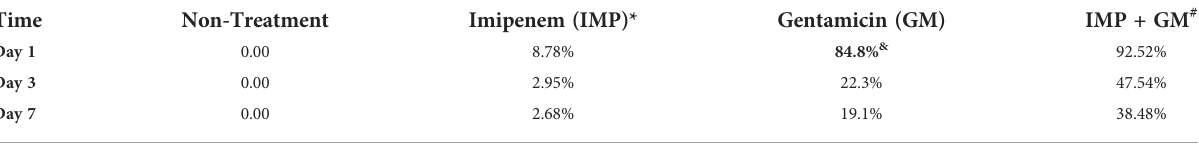
TABLE 4 Mono versus combination therapy of antibiotics against bio fi lm infections (bactericidal rate; 128× MIC; IMP: 160 mg/kg and GM: 64 mg/ kg; in vivo ).